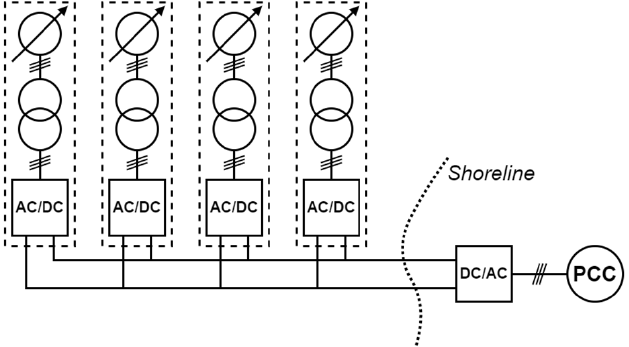
Figure 22. Topology T4. A parallel-connected DC collection grid with a transformer and rectification in the marine energy converters.